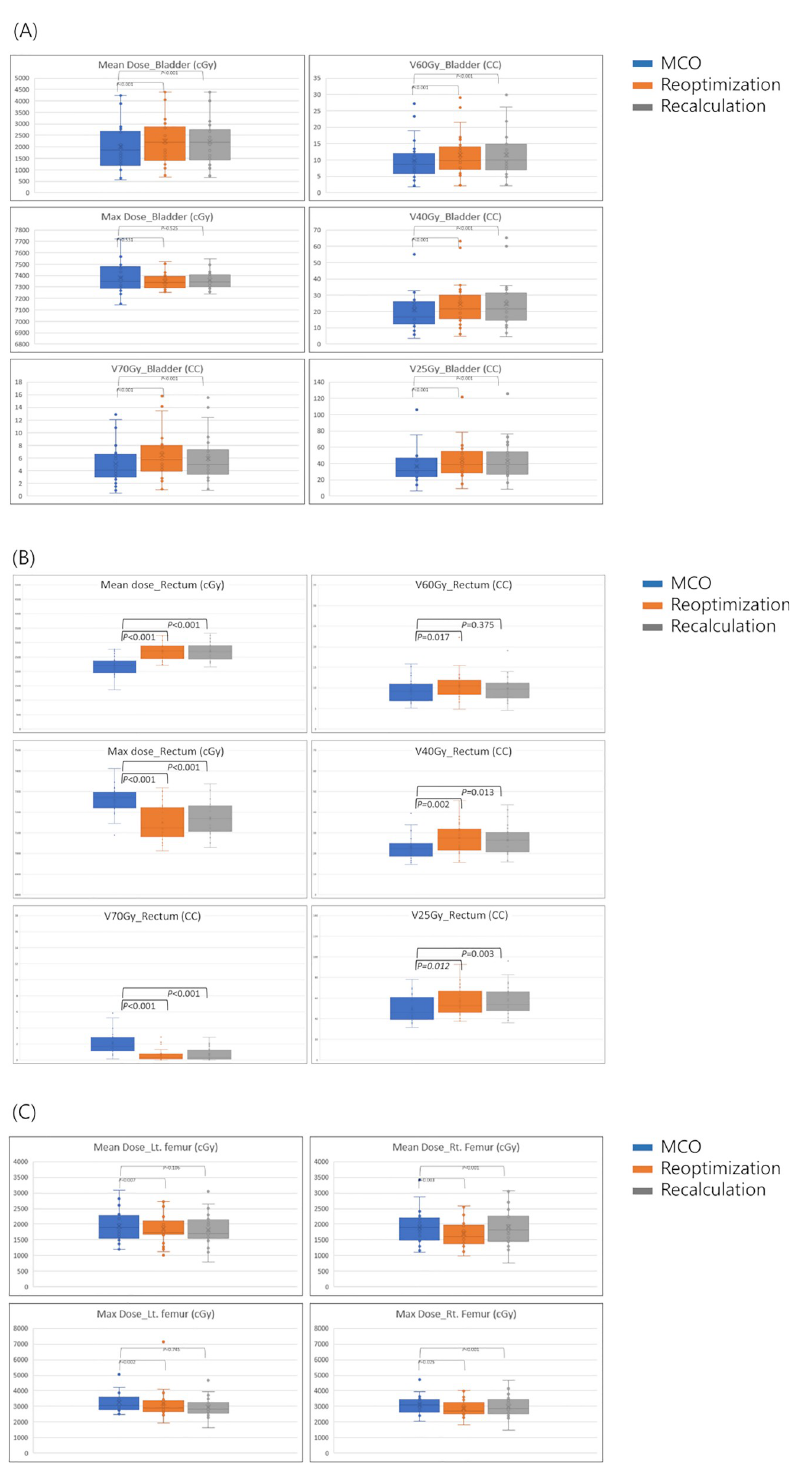
Fig 5. Boxplots of D max, D mean , V70, V60, V40, V25 for (A) bladder, (B) rectum, and (C) D max and D mean for the bilateral femoral heads. Abbreviations: D min , Minimum dose; D mean , mean dose; D max , maximum dose; V(n), volume receiving n